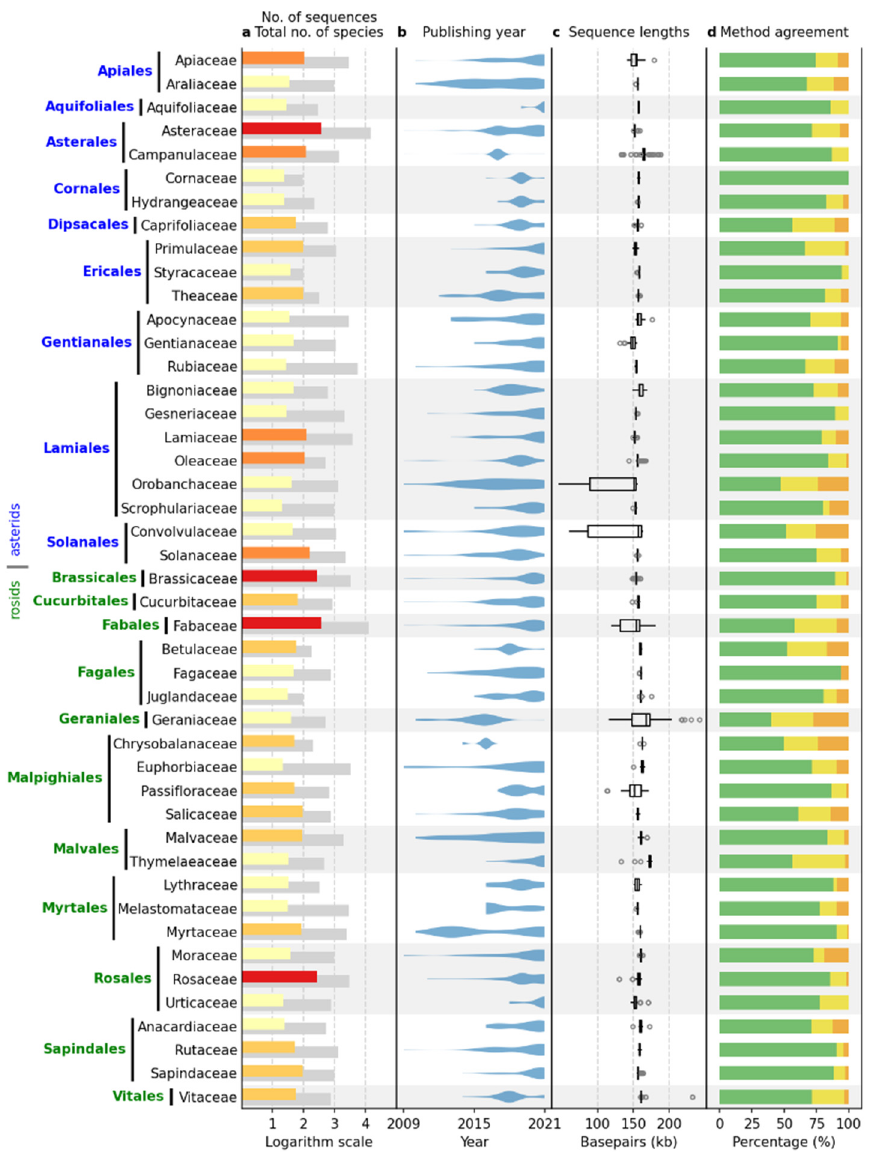
Figure 1. Availability of the complete chloroplast genome, publishing years, sequence lengths, and the outcome of IR identification using six annotation tools in different families of asterids and rosids. Represented families contain 20 or more sequences. ( a ) Total number of species (gray bar) and number of available complete chloroplast sequences (colored bar) in NCBI, where yellow represents 20–49, orange 50–99, red 100–199, and brown ≥ 200 sequences. ( b ) Violin plots of the number of sequences published in NCBI per year. ( c ) Box plots of complete chloroplast sequence lengths. ( d ) The proportion of different outcomes of IR identification: six annotation tools produced the same outcome (green), two different outcomes (yellow), and three or more different outcomes (orange). Outcomes were treated as the same if the lengths of the identified IR differed by less than 10 bp.